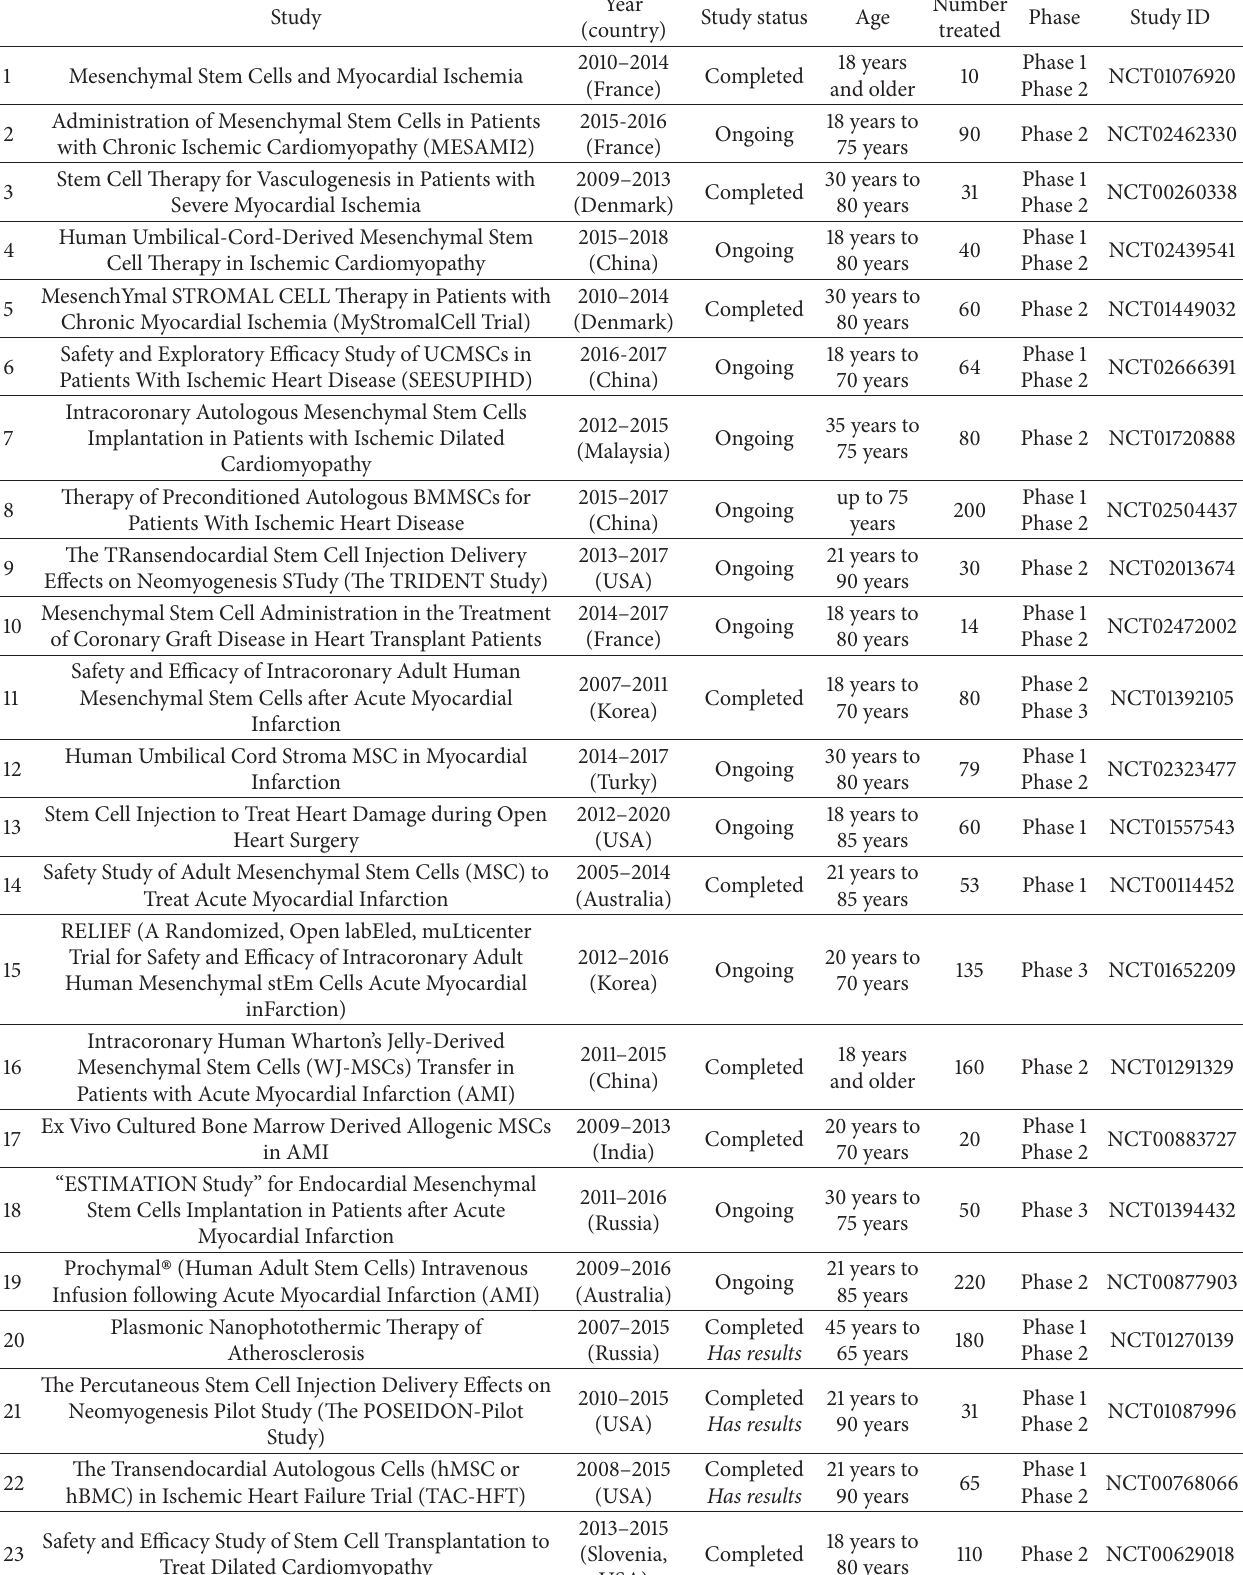
Table 1: Clinical trials with mesenchymal stem cells